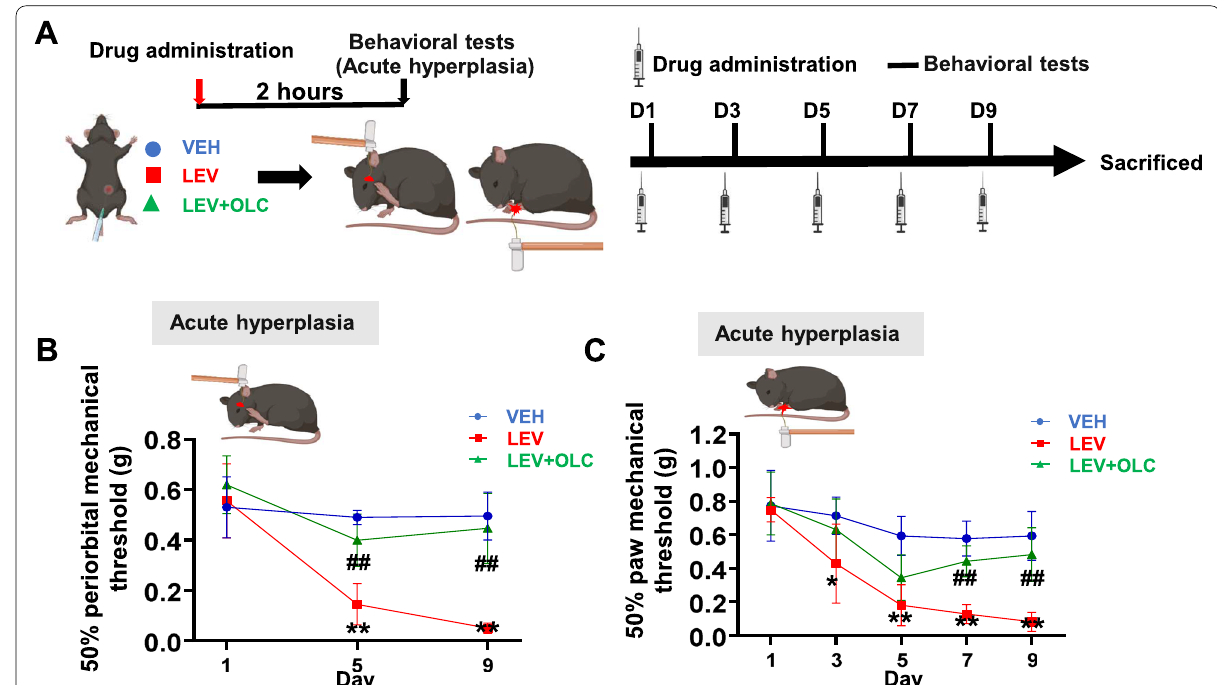
Fig. 5 CGRP receptor antagonist (olcegepant) alleviated acute hyperalgesia in the LEV-induced chronic migraine model. A. Representative schematic diagrams and procedures for the behavioral tests (Created with BioRender.com). B‑C . Repeated LEV administration induced mechanical hyperalgesia of periorbital area ( B ) and hindpaw ( C ), alleviated by OLC. Two-way ANOVA with the Tukey post hoc tests, * P < 0.05, ** P < 0.01, LEV group compared with the VEH group, n 8/group; # P < 0.05, # # P < 0.01, LEV group compared with the LEV = Abbreviations: VEH, vehicle; OLC, olcegepant; LEV, levcromakalim